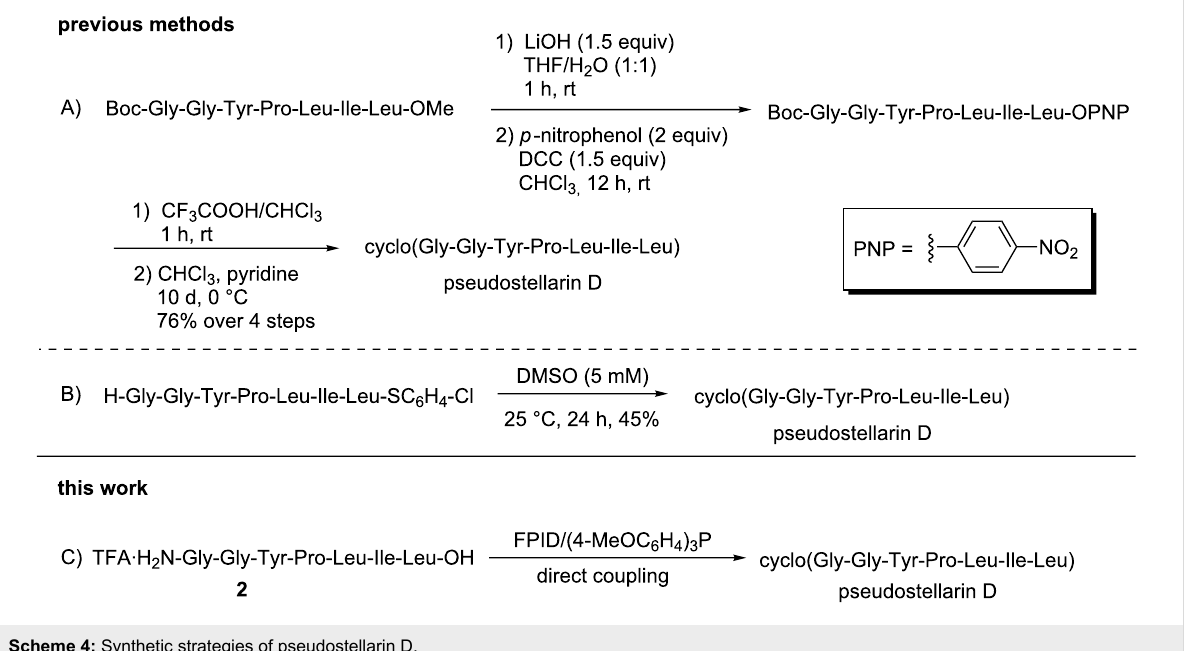
Scheme 4: Synthetic strategies of pseudostellarin